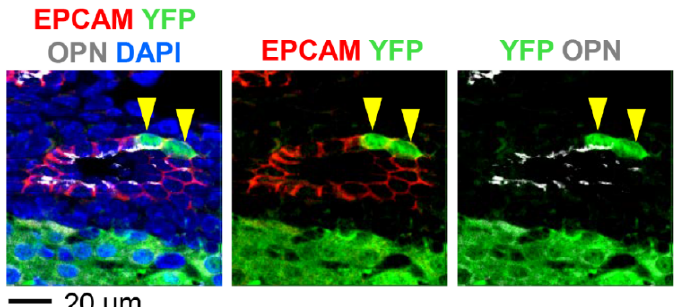
Figure 2. Quantification of the percentage of AAV8-CMV-Cre / YFP-labeled cells within CK19-expressing cholangiocytes and HNF4 α -expressing hepatocytes. Error bars represent the standard deviation of the mean ( n = 5–11 mice per group). * p < 0.05.